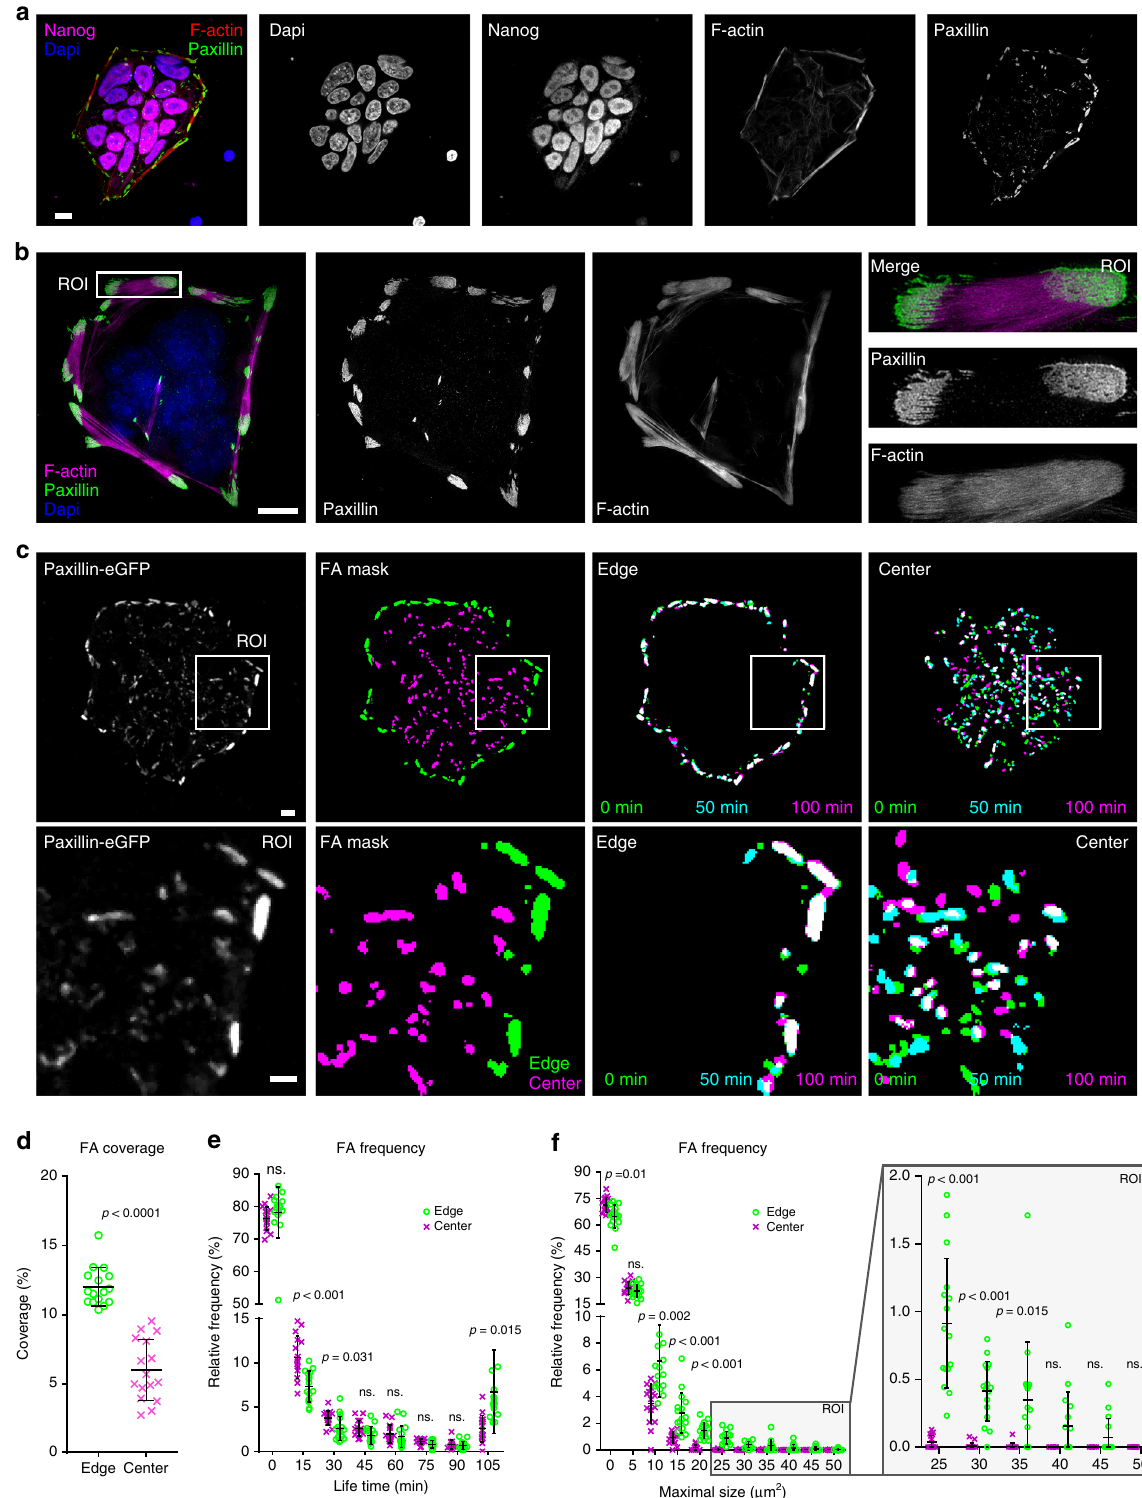
These observations are in line with previous work reporting that hPSCs differentiate faster when stimulated with the morphogen BMP-4 when cultured on a 650 nm nano-grated pattern compared to a uniform substrate 21 . Together, these data indicate a link between cornerstone FA architecture and pluripotency maintenance, and prompted us to investigate the nanoscale architecture of these adhesions in more